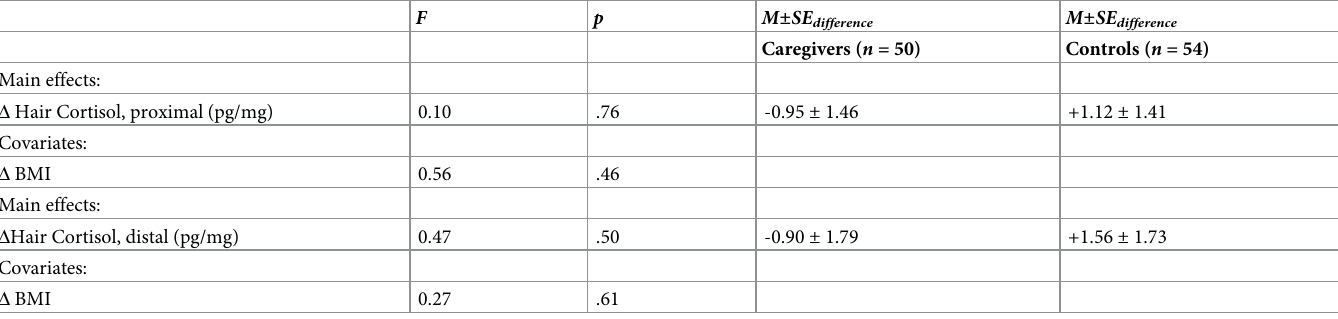
Table 2. One-way ANCOVA for group differences in hair cortisol change from baseline to 2 years, adjusting for change in BMI from baseline to 2